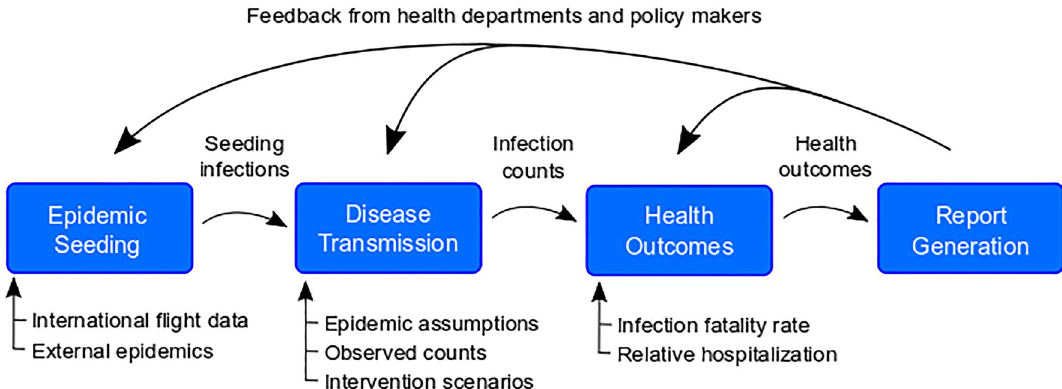
Figure 1. Overview of the pipeline. The pipeline has four modules, each with specific inputs that can be specified by the user. First, we identify when and in which model locations epidemics are seeded using an air importation model or confirmed case data. Second, the epidemic seeding events are used to initiate the disease transmission model, which is informed by our epidemiological assumptions and intervention scenarios. The disease transmission model produces daily incident infection counts and infection prevalence. Next, we calculate health outcomes like hospitalizations and ICU admissions from these infection counts according to assumptions about health outcome risks and infection fatality ratios. Finally, these health outcomes may be summarized using templates and functions from the report generation component of the